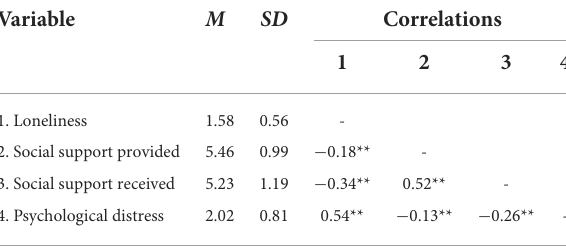
TABLE 1 Mean, standard deviation and bivariate correlations of key variables, wave 1. Variable